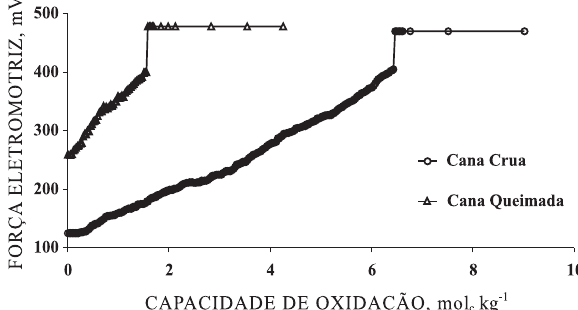
Figura 2. Titulações redox de 6,25 mg de ácidos húmicos isolados da camada de 0–0,20 m de solo sob cana crua e sob cana queimada, suspensos em 125 mL de KCl 0,05 mol L -1 e solução-tampão fosfato 0,05 mol L -1 a pH 7,00. Os pontos de , = inflexão das curvas correspondem a f.e.m cela kg -1 para cana 405 ± 7 mV e COx = 6,44 ± 0,06 mol c crua e a f.e.m = 406 ± 5 mV e COx = 1,64 ± cela kg -1 para cana 0,08 mol c